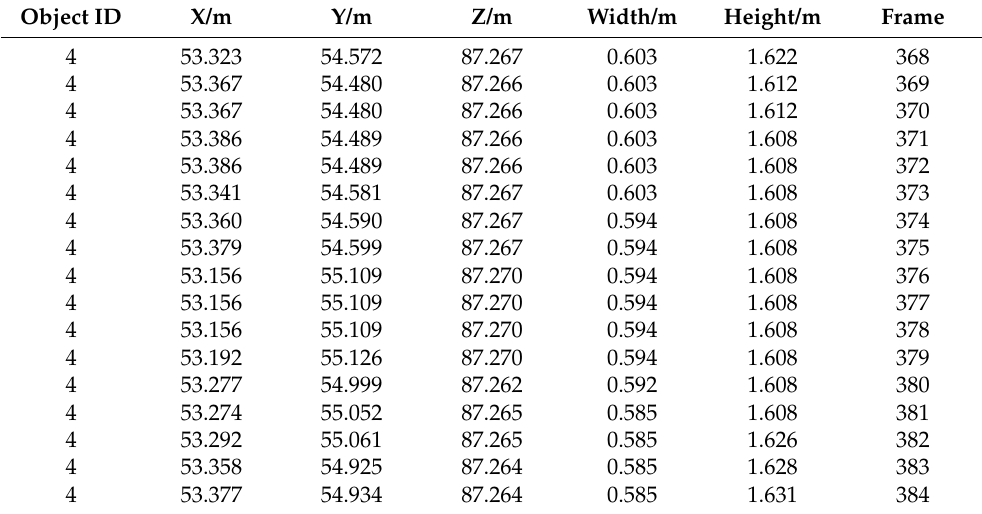
Table 3. Part of the spatial – temporal information of the fourth object.